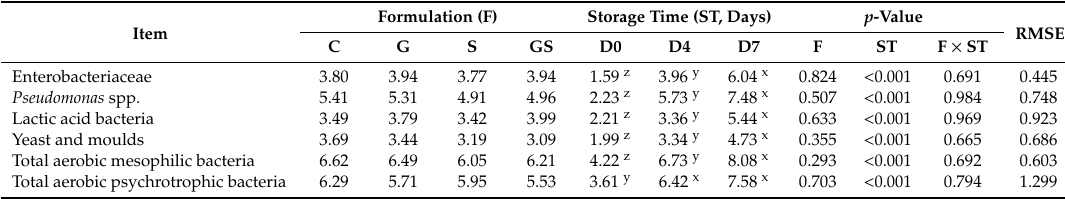
Table 5. Microbial determinations on raw rabbit